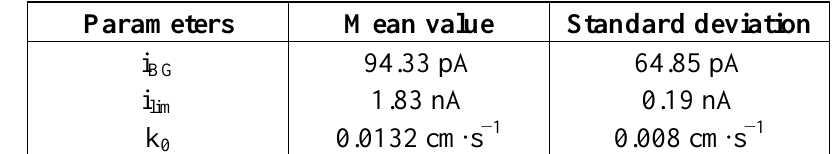
Table 1. Mean value and standard deviation of the background current i i , and transfer rate k lim